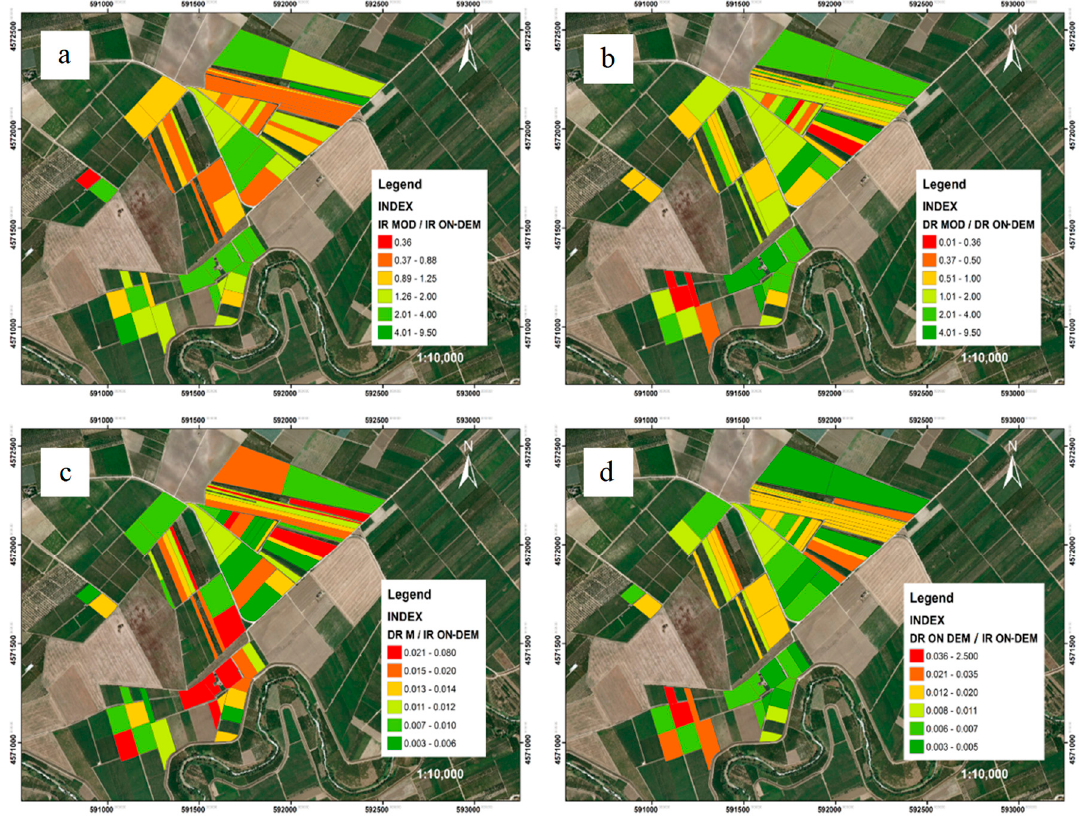
Figure 11. Maps of four indices: ( a ) Ratio of irrigation volumes model / irrigation volumes on-demand (IR MOD / IR ON-DEM); ( b ) ratio of drainage volumes model / drainage volumes on-demand (DR MOD / DR ON-DEM); ( c ) ratio of drainage volumes model / irrigation volumes on-demand (DR MOD / IR ON-DEM); ( d ) ratio of drainage volumes on-demand/irrigation volumes on-demand (DR ON-DEM/IR ON-DEM).